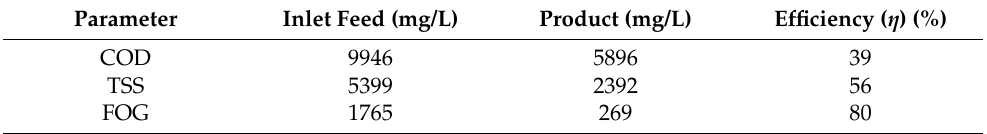
Table 1. Raw and pre-treated poultry slaughterhouse wastewater (PSW) characteristics average range.